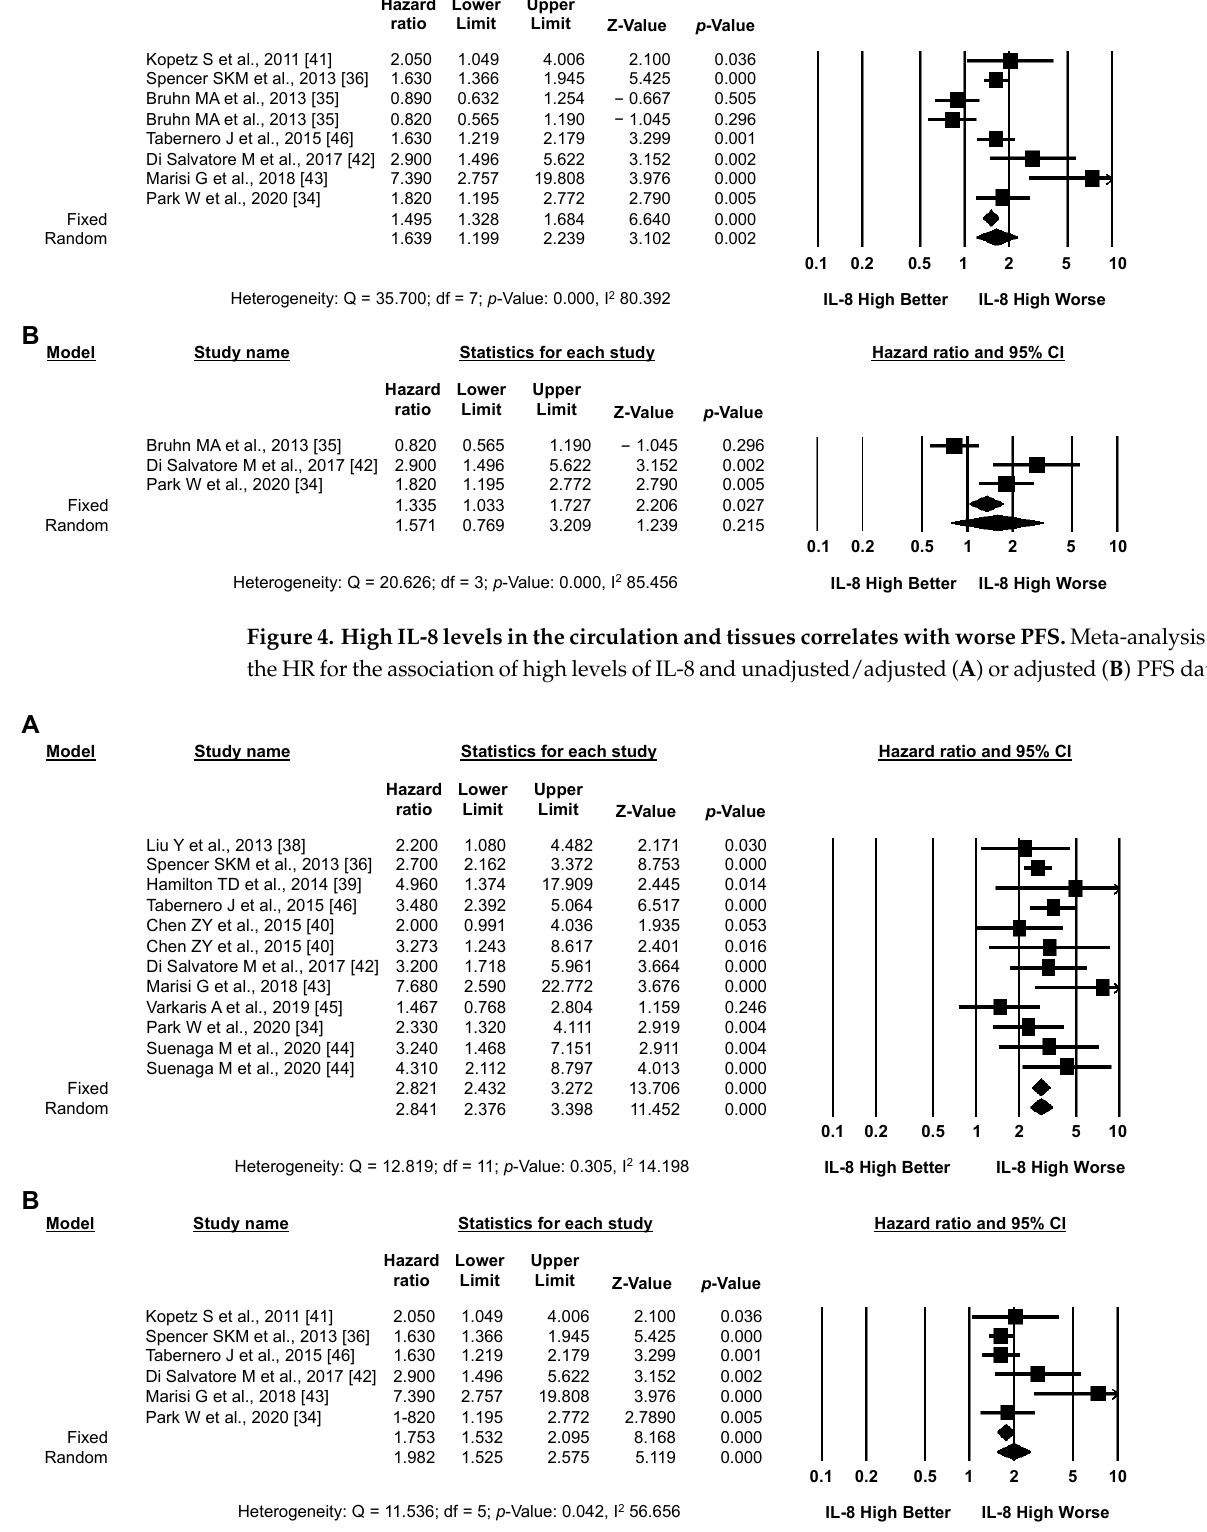
Figure 5. High IL-8 levels in the circulation correlates with worse OS and PFS. Meta-analysis of the HR for the association of the source of IL-8 (plasma or serum) and OS ( A ) or PFS ( B ) data.